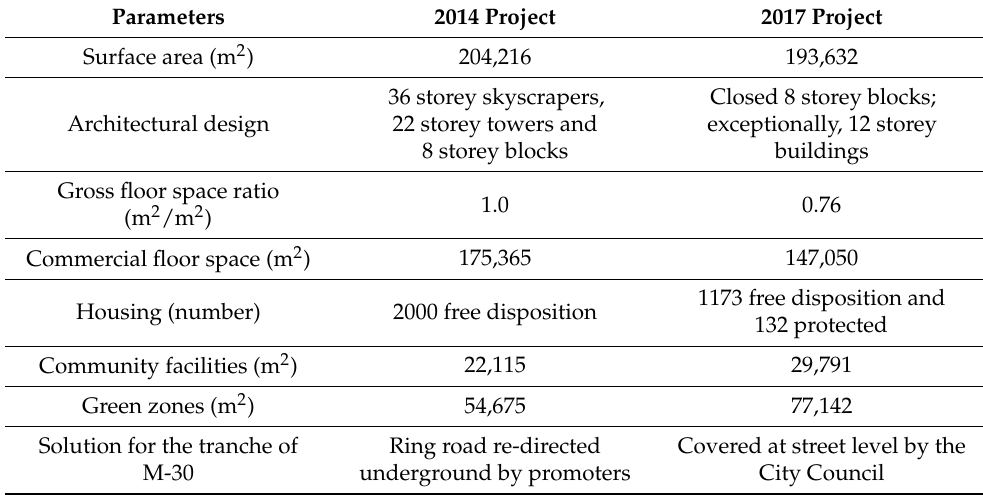
Table 1. Principal urbanism parameters in the projects of 2014 and 2017 (source: the author from [48]). Parameters 2014